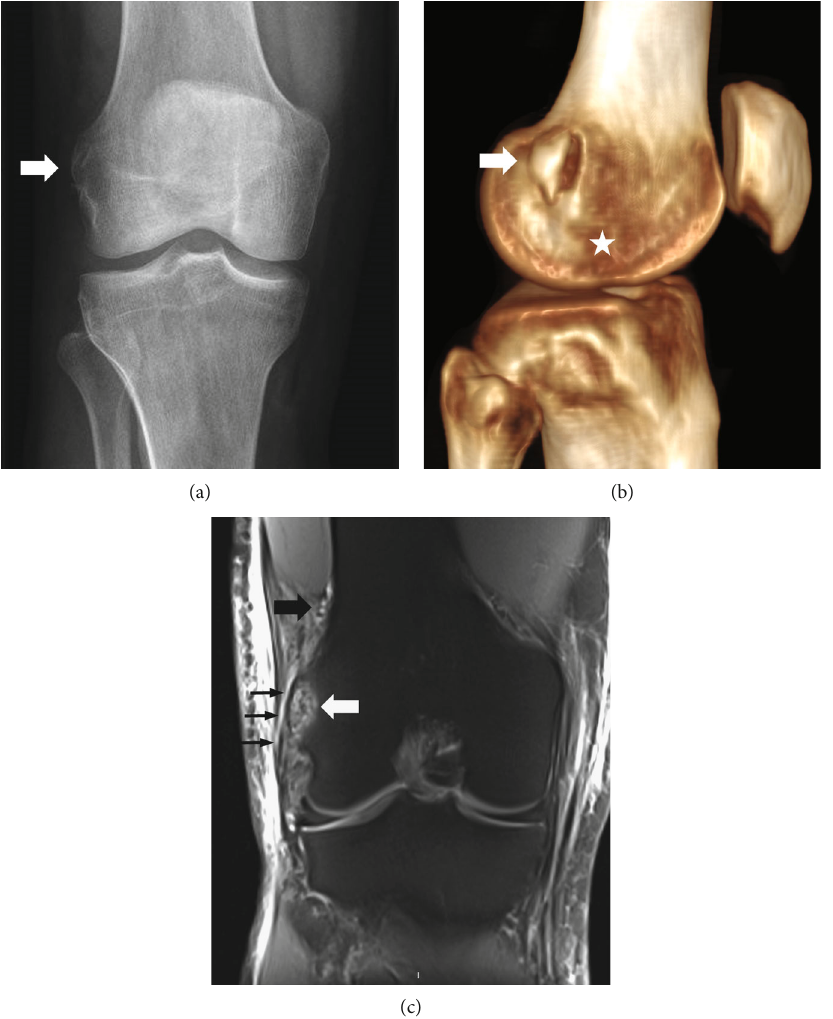
Figure 3: Patient case 2. (a) AP right knee X-ray at day 1 showing the avulsion fracture of the femoral insertion of the LCL (white arrow). (b) Lateral view of a 3D reconstruction of the right knee CT at day 1 showing the avulsed bony fragment of the femoral insertion of the LCL (white arrow). The white star shows insertion site of the popliteal tendon. (c) Proton density coronal MRI obtained at day 3 showing an intact LCL (small black arrows) attached to the avulsed bony fragment of the femoral insertion (large white arrow). Note the superior lateral genicular vessels (large black arrow) above the bony